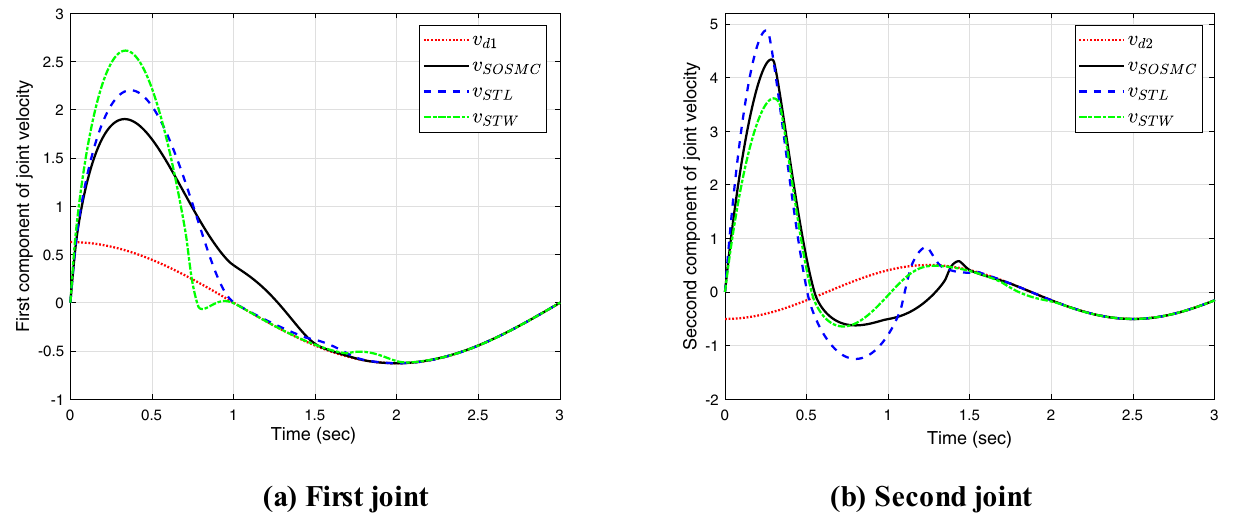
Fig. 9 Comparison of velocitites v 1 = ̇ q 1 and v 2 = ̇ q 2 of first and second joints for SOSMC, STW and